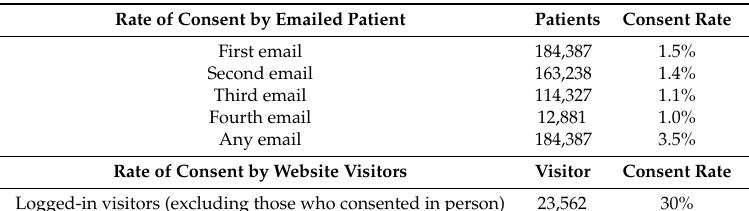
Table 1. Results of the email campaign (June 2014–January 2016).